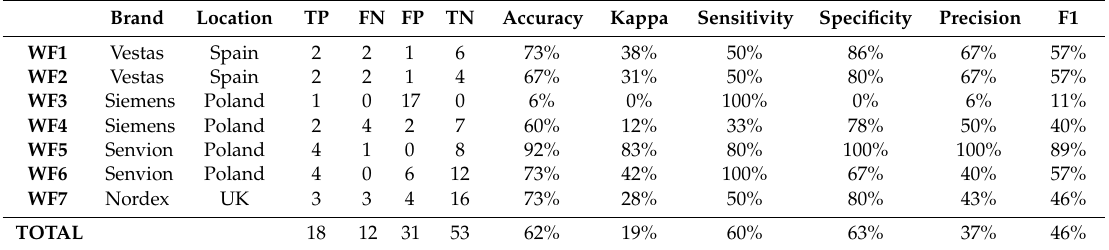
Table 5. Results obtained using an alarm-based predictor. WF stands for Windfarm, TP True Positive, FN False Negative, FP False Positive and TN True